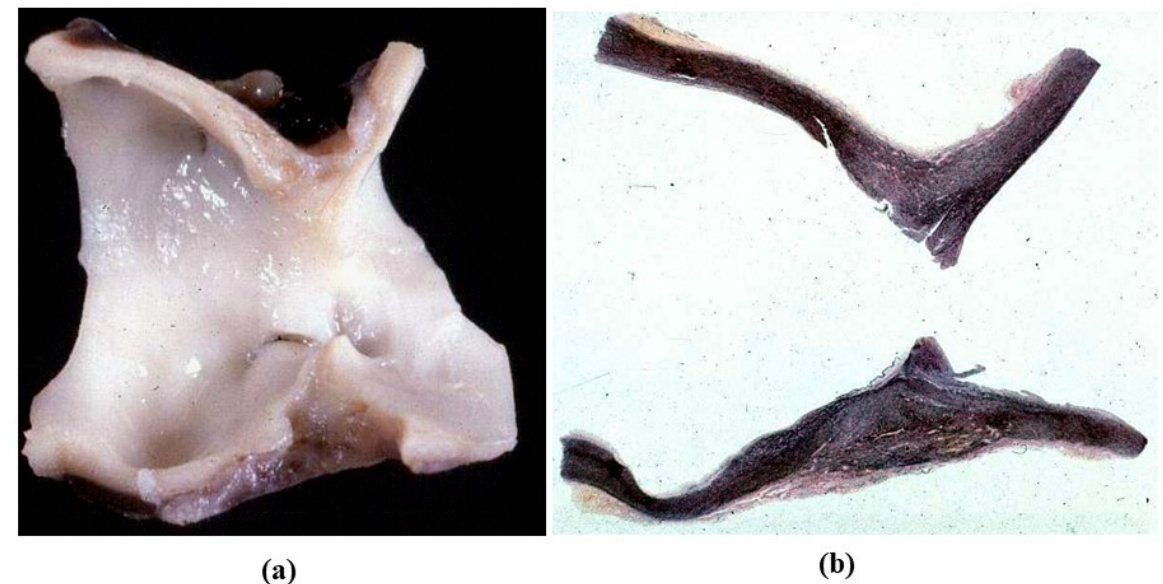
Figure 8. Isthmic aortic coarctation. ( a ) Plication at the aortic arch. ( b ) Corresponding histology. (Weigert Van Gieson stain).